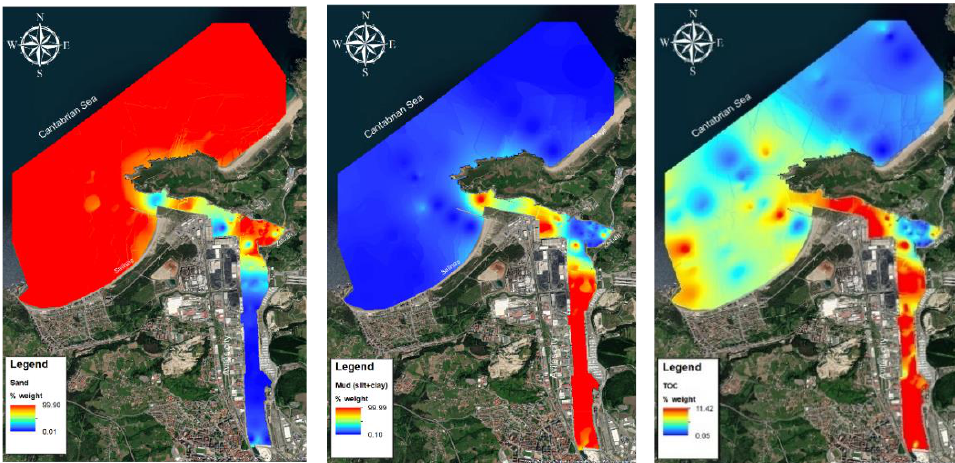
Figure 2. Spatial distribution of the sand fraction, mud (silt + clay) fraction and TOC concentrations in the surface sediments of the study area.